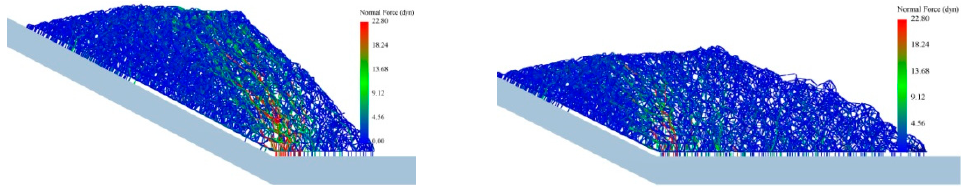
Figure 14. Diagram of normal force of wet soil sliding at the slope foot ( γ = 0.2 J / m 2 , d = 1